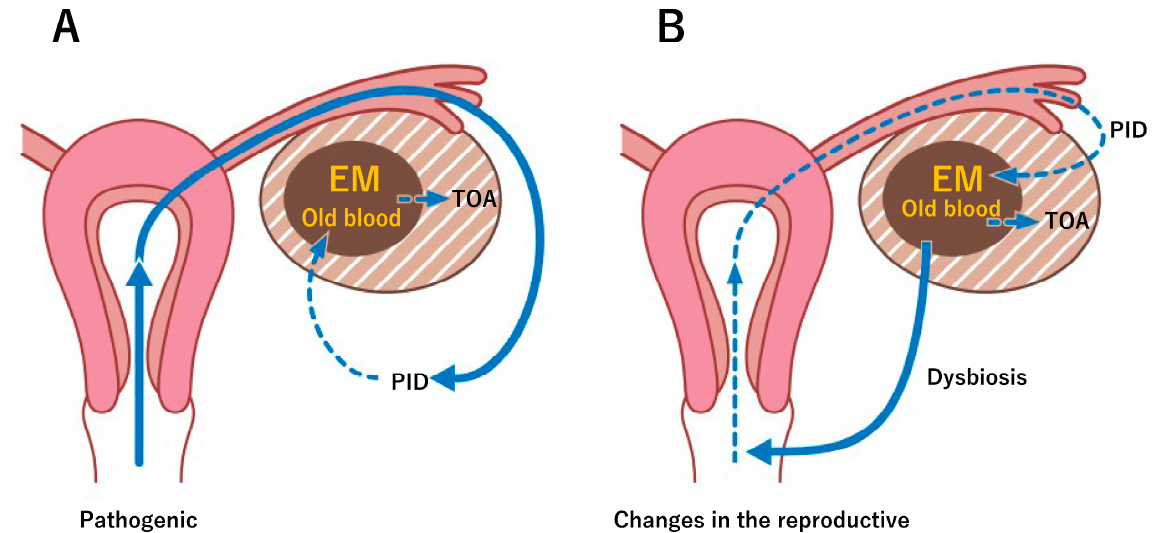
Figure 2. Pathophysiological mechanisms underlying the bidirectional relationship between en- dometriosis and PID. ( A ) Ascending genital tract infection causes PID, followed by secondary infection of endometriotic cysts, and ultimately TOA. ( B ) Endometriosis-associated microbiota dys- biosis induces pathogenic bacterial growth and pelvic inflammation, leading to secondary infections in endometriotic cysts and then the development of TOA. Bold arrows indicate the first trigger of infection, dotted arrows indicate the second infection.